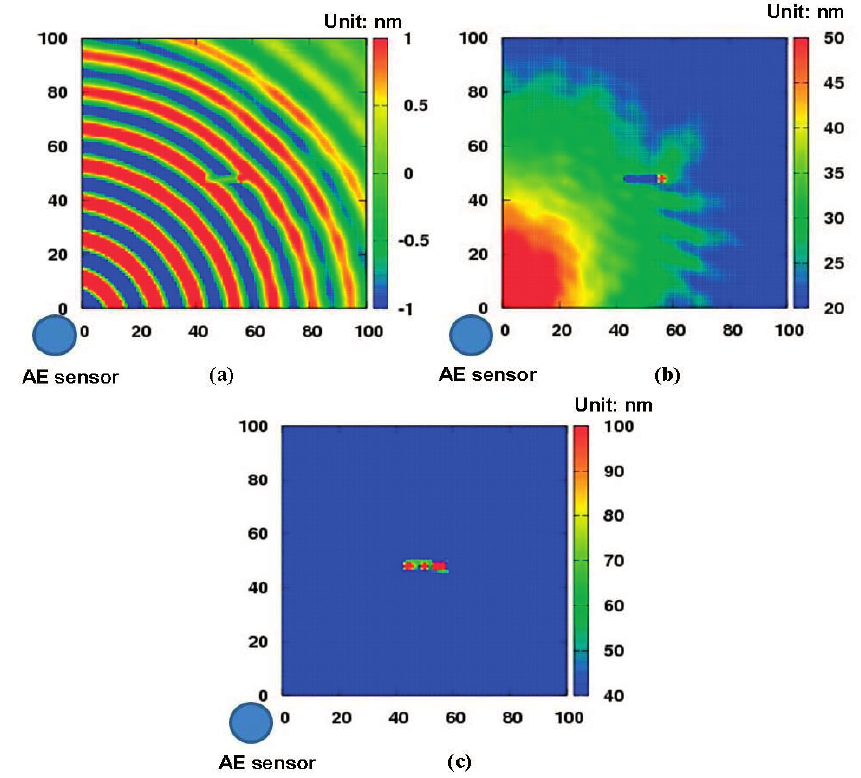
Figure 7. Diagnostic images (a 1 mm depth non-penetrative slit): ( a ) snapshot at 100 µs; ( b ) distribution image of kinetic energy; ( c ) the improved diagnostic